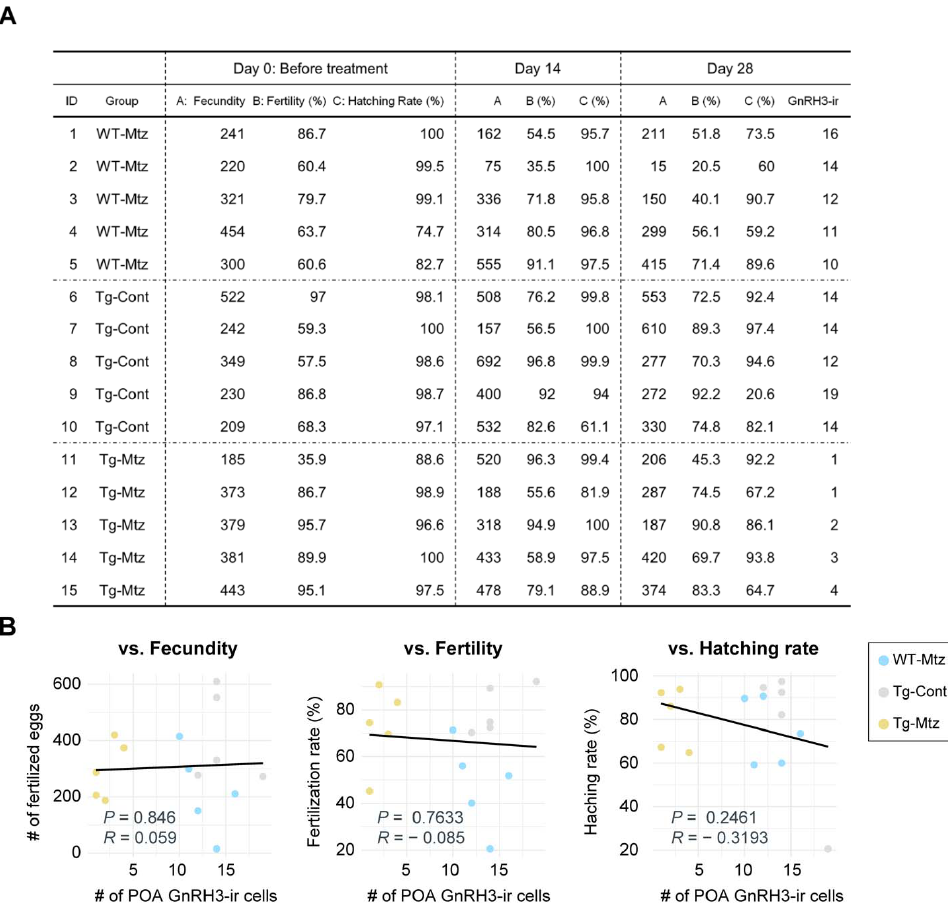
Figure 3. GnRH3 neuron ‐ ablated females exhibit normal fertility. ( A ) Number of fertilized eggs per spawn (fecundity), percentage of fertilized eggs (fertility), and hatching rate from the experimental females paired with WT males before treatment, and at 28 days of treatment. ( B ) Gonadosomatic index (GSI) ( n = 7–11). ( C ) Representative ovarian sections stained with hematoxylin and eosin. Scale bars, 500 μ m. Bottom panels, images of the intact ovaries with the corresponding GSI (mean ± SEM) adjacent to each image. Scale bars, 1 mm. WT ‐ Mtz, WT siblings treated with 2 mM metronidazole (Mtz); Tg ‐ Cont, Tg(gnrh3:Gal4ff; UAS:nfsb ‐ mCherry) treated with vehicle; Tg ‐ Mtz, Tg(gnrh3:Gal4ff; UAS:nfsb ‐ mCherry) treated with 2 mM Mtz. p > 0.05.